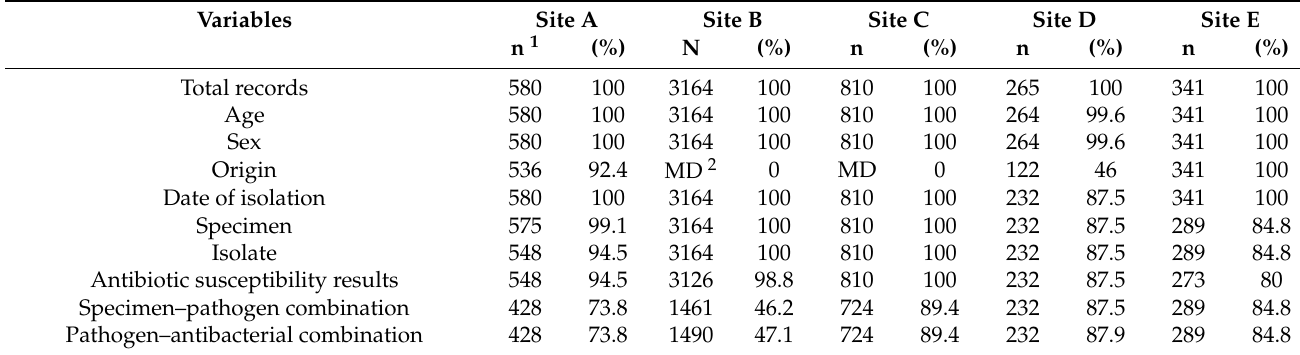
Table 3. Consistency of AMR surveillance data from five AMR surveillance sites in Province 3 of Nepal (January to June 2019).